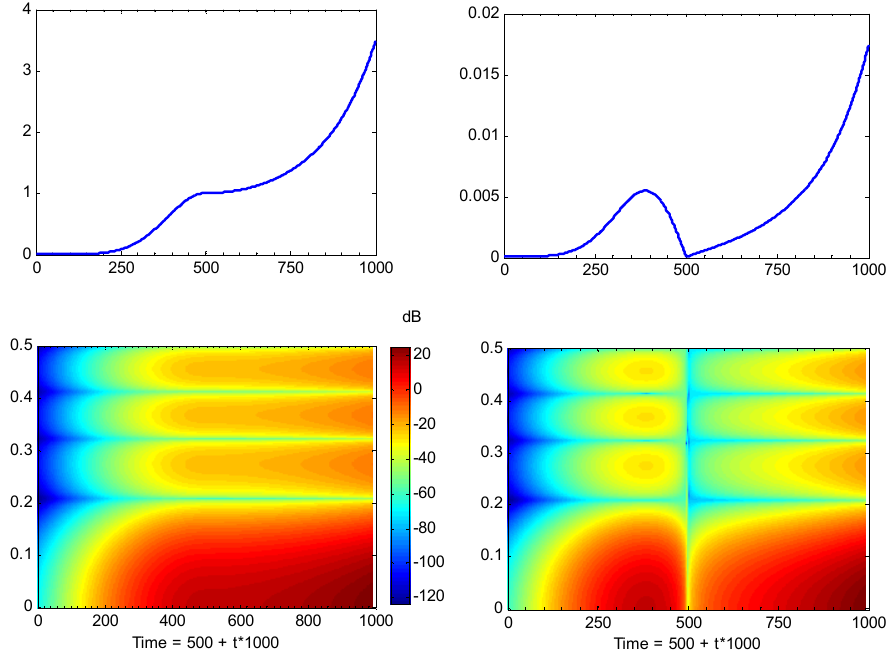
Fig. 2. The signal (1) (up left) sampled at every Δ t = 10 -3 with the temporal abscissa rescaled as time = 500+ t• 1000, the spectrogram of the signal (down left), the first difference series (upper right) and its spectrogram (down right). The units are arbitrary.